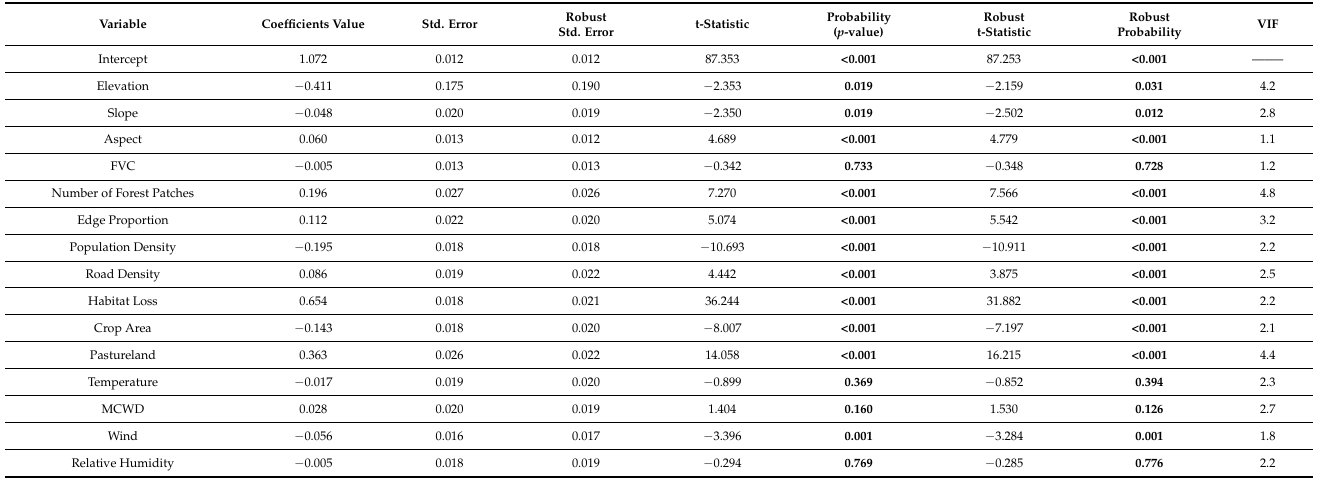
Table 2. OLS diagnostics